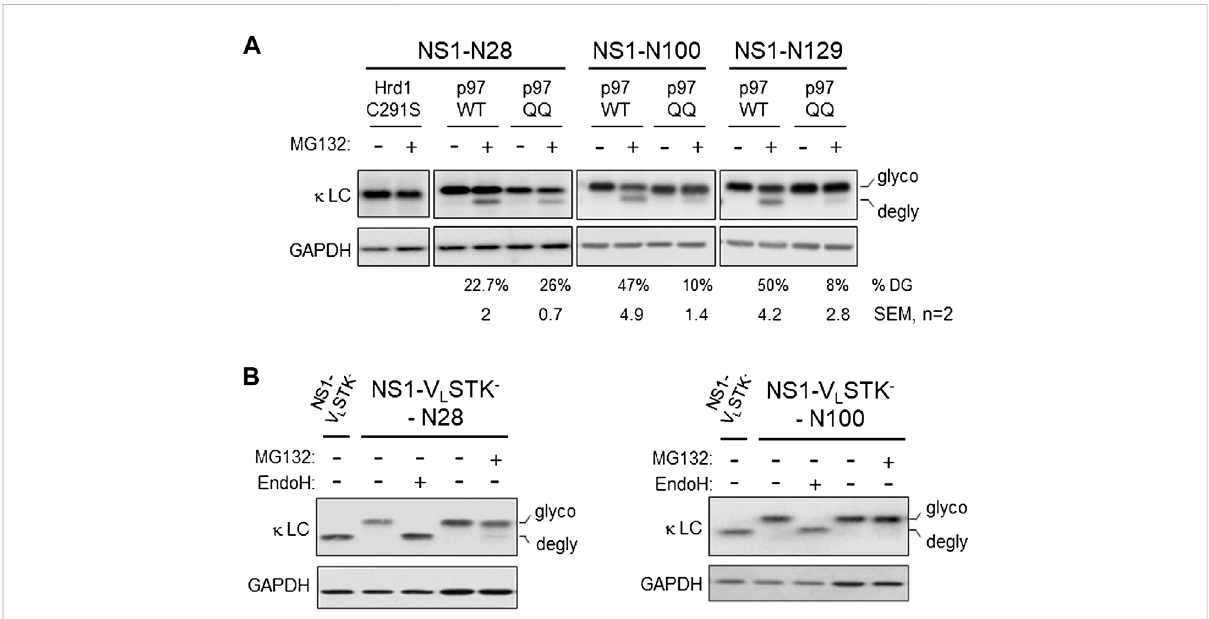
FIGURE 2 Retrotranslocation of NS1 does not require proteasomal activity but is dependent on ubiquitinationand p97. (A) Cells were co-transfected with NS1-N28,NS1-N100,orNS1-N129encodingconstructstogetherwitheitherp97WTorATPaseinactivep97QQmutant.Thenextday,aplateofeach was incubated with either 10 μ M MG132 (+) or DMSO (- control) for 3.5 h prior to lysis. Lysates were prepared and analyzed by SDS-PAGE coupled westernblottingwithgoatanti-mouse κ antiseraorGAPDHasacontrol.Thepercentdeglycosylationwasdeterminedasthefractionofthetotal amountofLCandisindicatedbeloweachlanealongwiththecalculatedSEM, n =2. (B) CellsweretransfectedwiththeNS1-V L STK - constructorNS1- V L STK - engineered with a single N-linked glycan on the V L domain at N28 or N100. Prior to lysis, one dish of each glycosylated construct was incubated with MG132 (+). Lysates were prepared and one sample of each glycosylated construct was treated with Endo H (+) as indicated. Samples were analyzed as in Figure